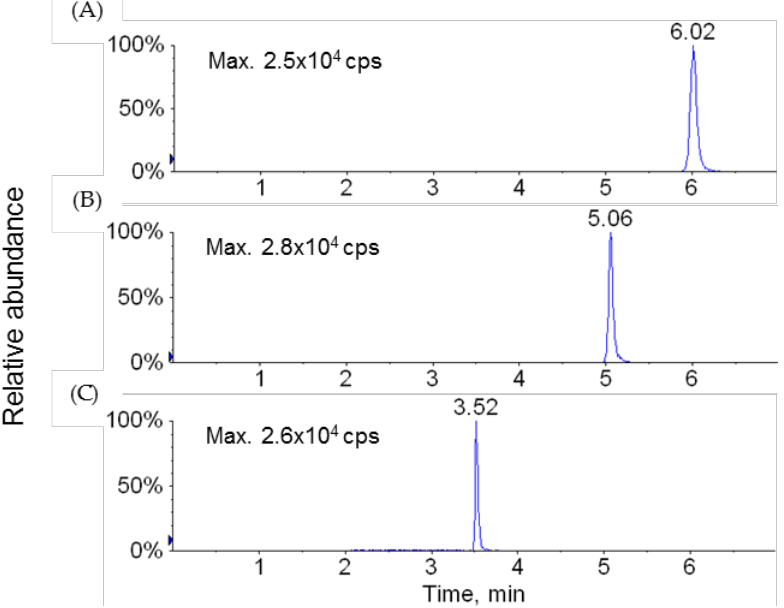
Figure 7. Representative MRM chromatograms acquired from LC-MS/MS analysis of LW6 ( A , m / z 434 → 227), APA ( B , m / z 285 → 227), and the internal standard ( C , m / z 175 →